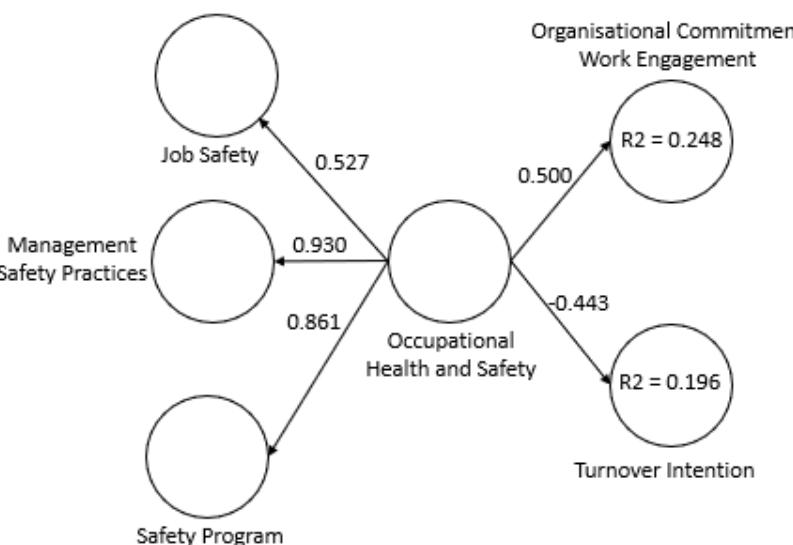
Figure 2. Structural equation model without mediation.